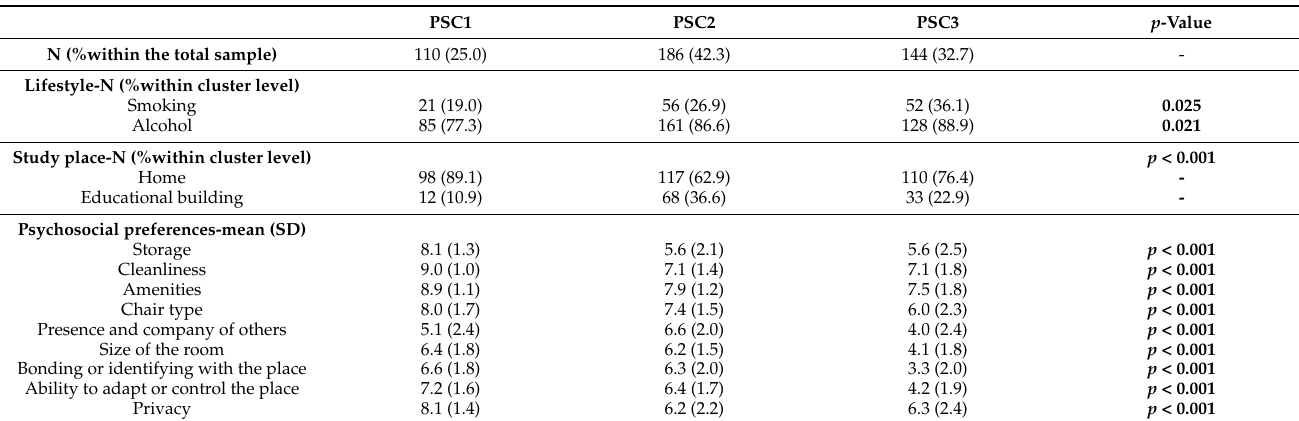
Table 4. Descriptive of psychosocial